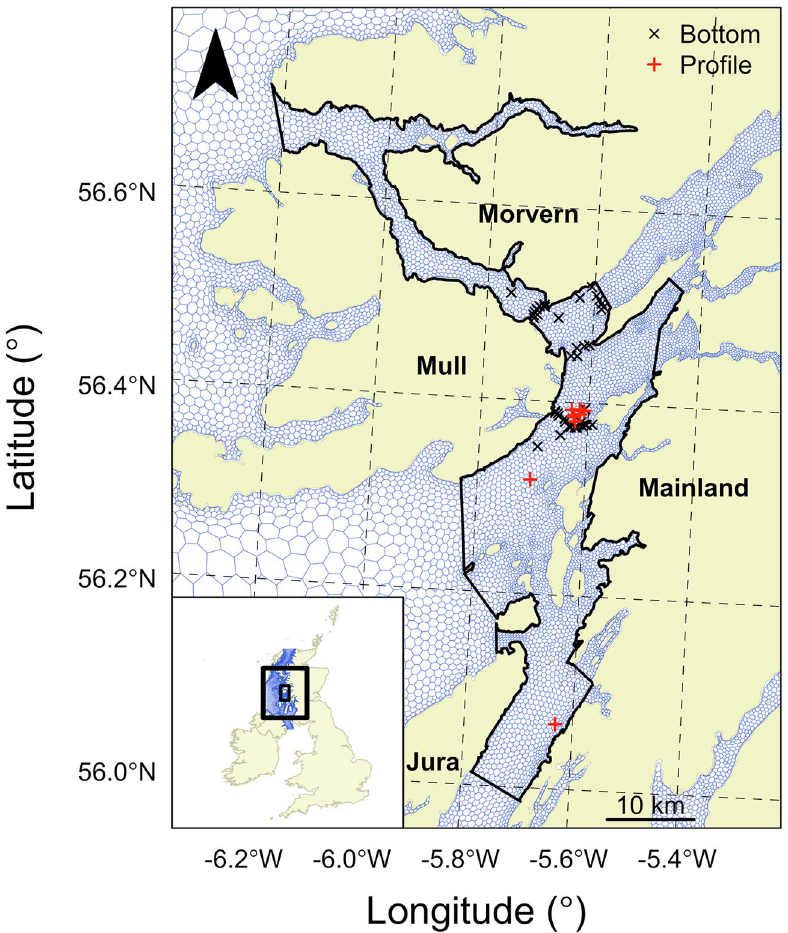
Figure 1. The study site. The inset shows the location of the study site in the British Isles, with the WeStCOMS mesh shown in blue and the study site enclosed within the black rectangles. The main figure shows the study site, including the mesh around nodes (connecting the elements in the native triangular mesh) and the Marine Protected Area (in black). Acoustic receivers that recorded detections associated with bottom-temperature observations recorded by archival tags are marked in black ( n = 40). Recreational angling locations associated with temperature-depth profiles are marked in red ( n = 8). The coordinate reference system is British National Grid and the north arrow points to grid north. Gridlines mark lines of longitude and latitude. Coastline data were sourced from the Database of Global Administrative Areas 66 . For a higher resolution map, see Supplementary Fig.